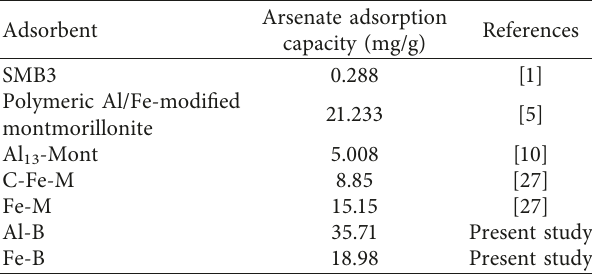
Table 6: Comparison of adsorption capacity with other adsorbents.